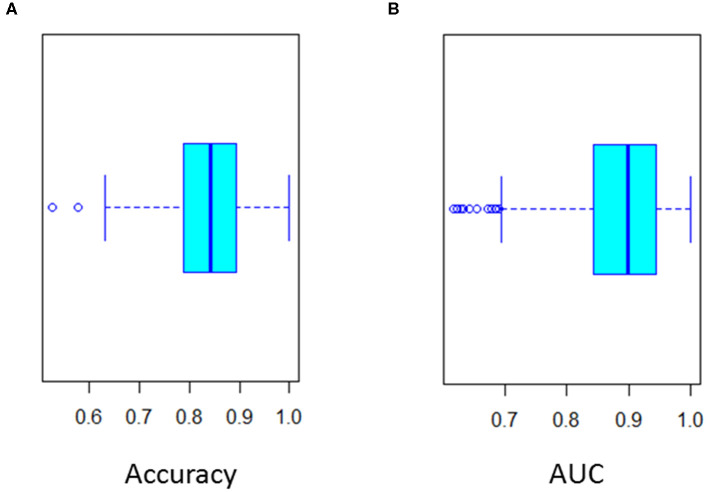
Twenty-fold cross validation of multivariate logistic regression analysis. (A) Accuracy (Mean 0.85) and (B) ROC curve AUC (Mean 0.89) of the cross validation.